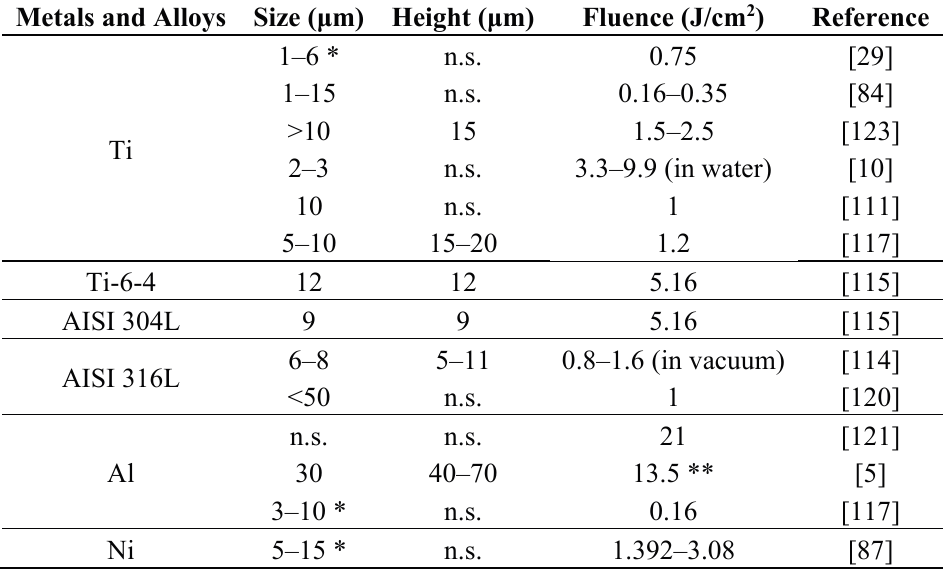
Table 5. Characteristics of columnar structures on different metals and alloys. * Values are estimated from the SEM images. ** The authors reported peak fluence value. n.s. = not specified.